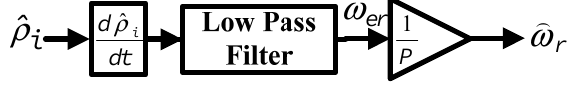
Figure 2. Rotor speed estimation.